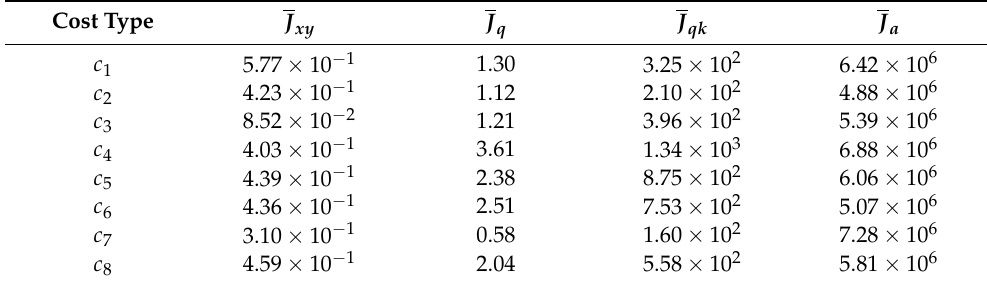
Table 5. Comparison of quality indicators depending on the various cost for control type Ω .